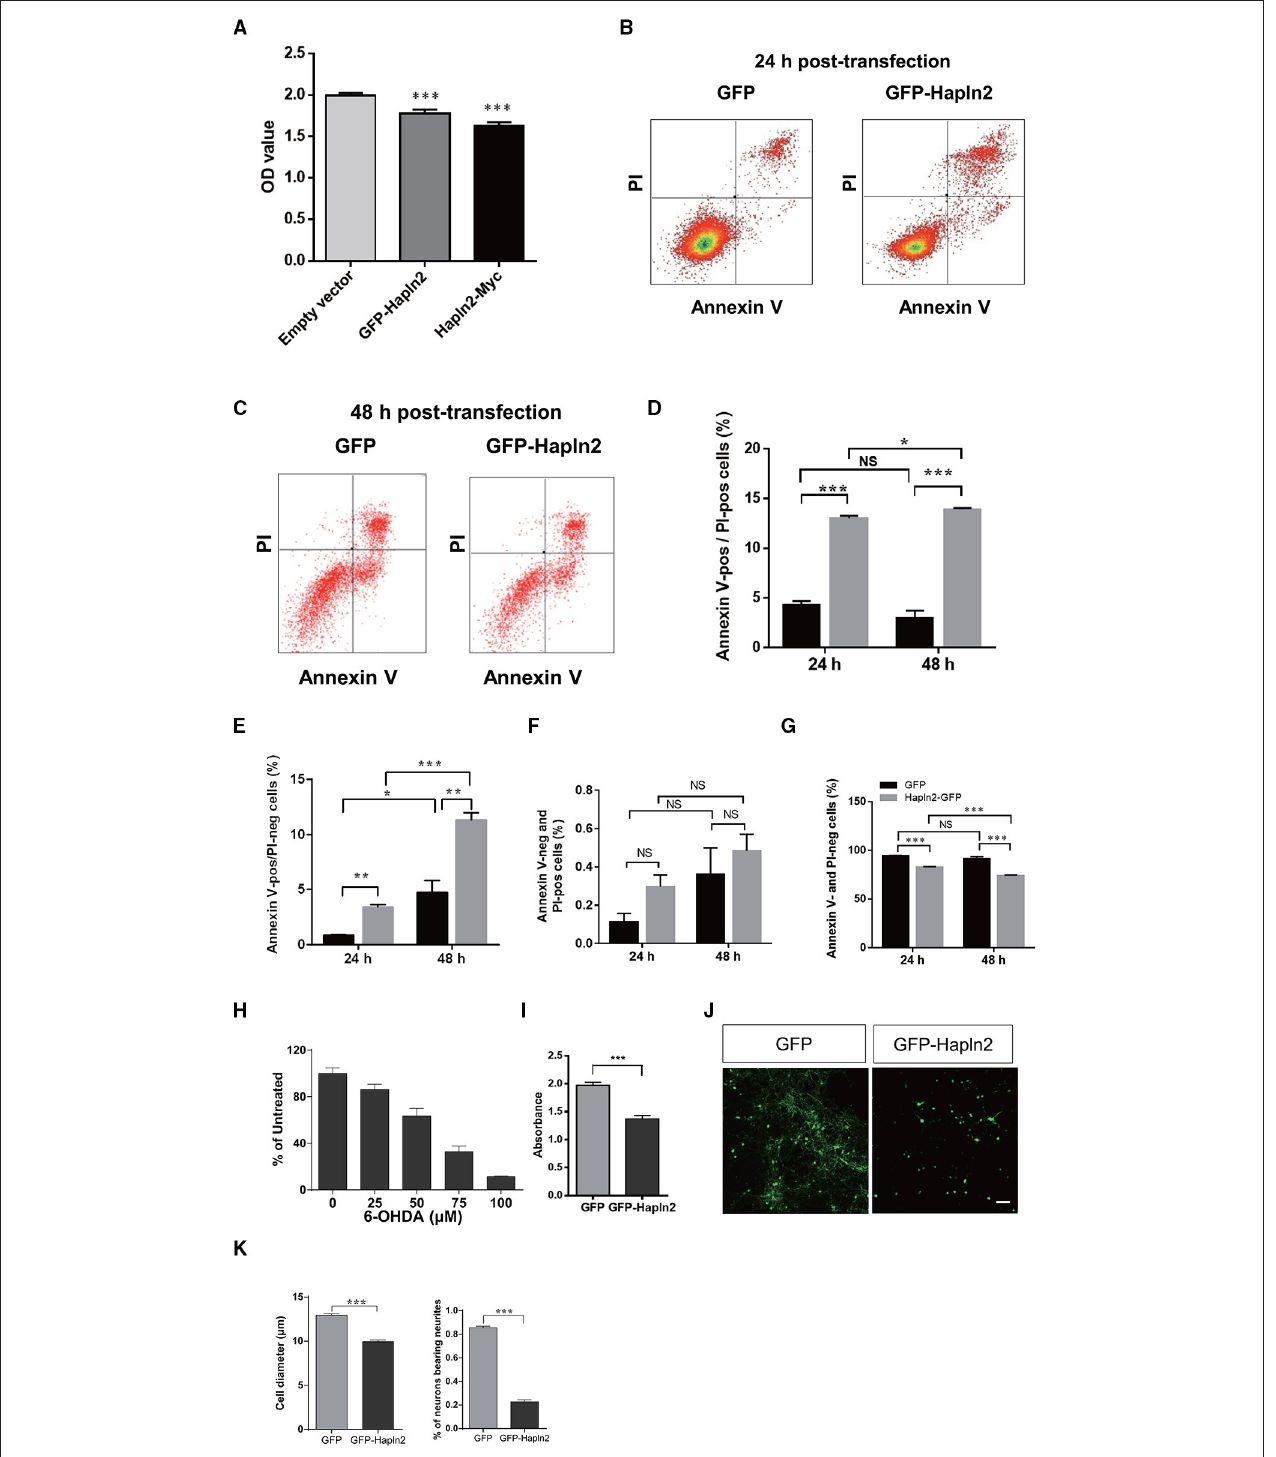
FIGURE 4 | Over-expression of Hapln2 reduces the viability of MES23.5 cell and primary cortical neurons. (A–C) The viability of MES23.5 cell was evaluated by MTT assay (A) or flow cytometry analysis (B,C) 24 or 48h after transfection with Hapln2 plasmids. (D–G) Quantitative data shown in (B,C) . (H) The survival ability of MES23.5 cell after 6-OHDA treatment. (I) The viability of MES23.5 cell transfected with Hapln2 plasmids following 6-OHDA challenge. Data are expressed as mean ± S.E.M ( n = 6 in A , n = 3 in D–H , n = 4 in I ). (J) Representative photomicrographs showing the morphology of primary cortical neurons 24h after GFP-Hapln2 plasmids transfection. Scale bar = 20 µ m. (K) Quantitative data of the neuronal soma diameter and the percentage of neurons bearing neurites in (J) . Data are expressed as mean ± S.E.M ( n = 3). * p < 0.05, ** p < 0.01, *** p < 0.001.